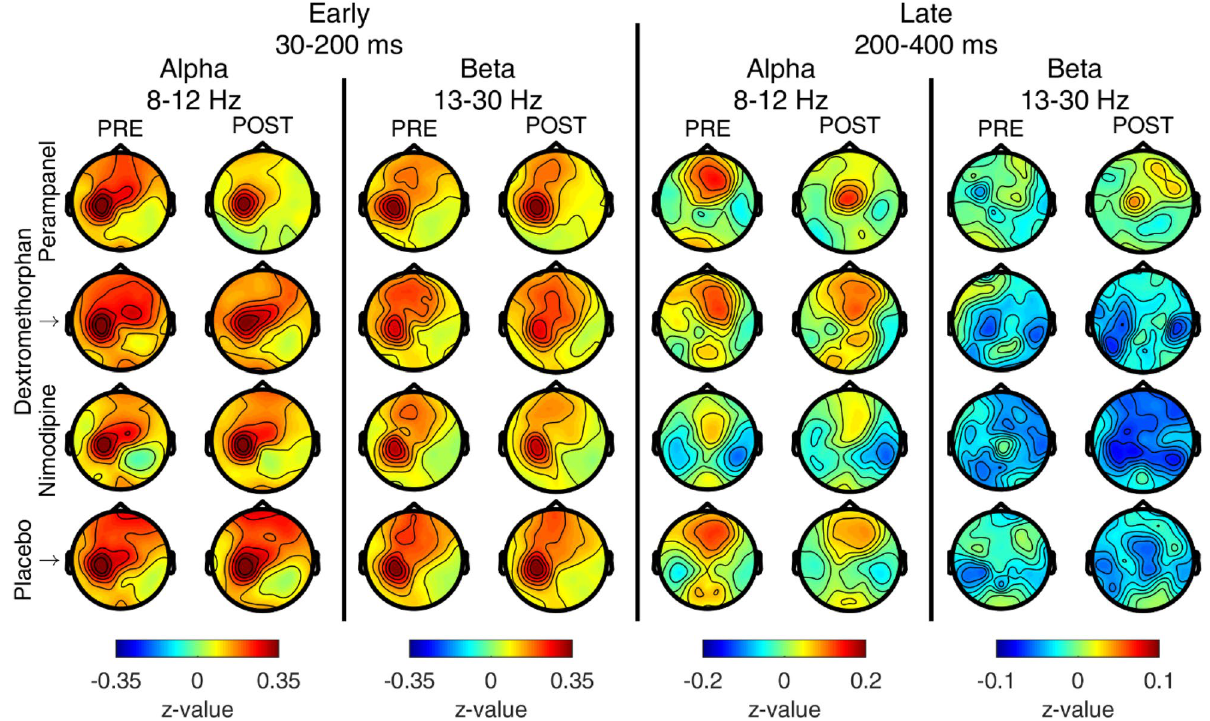
Figure 5. TMS-induced EEG oscillations (TIOs) pre- and post-drug application. In each panel, topographical maps of z-transformed baseline-normalized TIOs before (PRE, left columns) and after (POST, right columns) drug administration for all tested drugs (first row: perampanel, second row: dextromethorphan, third row: nimodipine, fourth row: placebo). The frequency bands of interest (alpha: 8–12 Hz, beta: 13–30 Hz) and the post-stimulus times of interest (early: 30–200 ms, late: 200–400 ms) are displayed in the topoplots as indicated at the top of this figure. Cluster statistics did not reveal any significant difference between post-drug vs. pre-drug TIOs for any of the tested drugs and time–frequency regions. Figure generated with MATLAB R2016a (https:// www. mathw orks. com) and the Fieldtrip Matlab toolbox (http:// www. field tript oolbox. org).